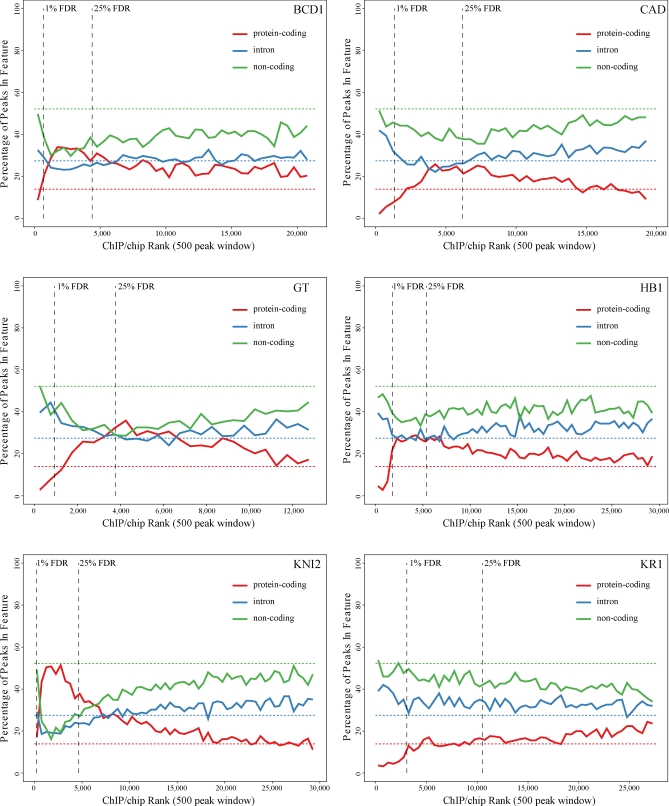
For Some Factors, Poorly Bound Regions Are Preferentially Found in Protein Coding SequencesPercentage of primary peaks in nonoverlapping windows of 500 peaks that are in protein coding (red), intronic (blue), and intergenic (green) sequence. Results are shown for windows down the rank lists to the 80% FDR cutoff. The percentages for each class of genomic feature are indicated as horizontal dotted lines in corresponding colors to the solid data lines. The 1% and 25% FDR cutoffs are indicated by vertical dotted lines. The panels show results for peak windows for BCD1, CAD, GT, HB1, KNI2, and KR1.